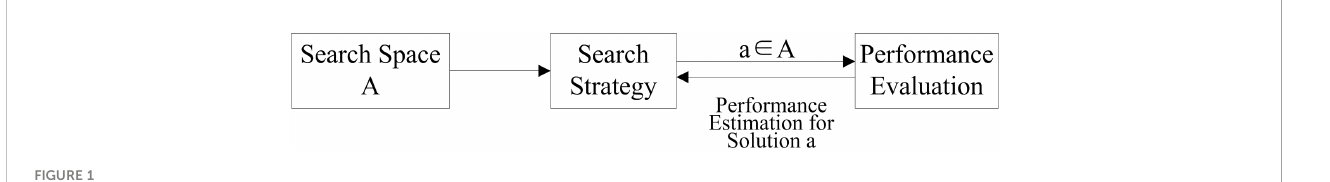
FIGURE 1 Basic processing procedure of neural architecture search for auto machine